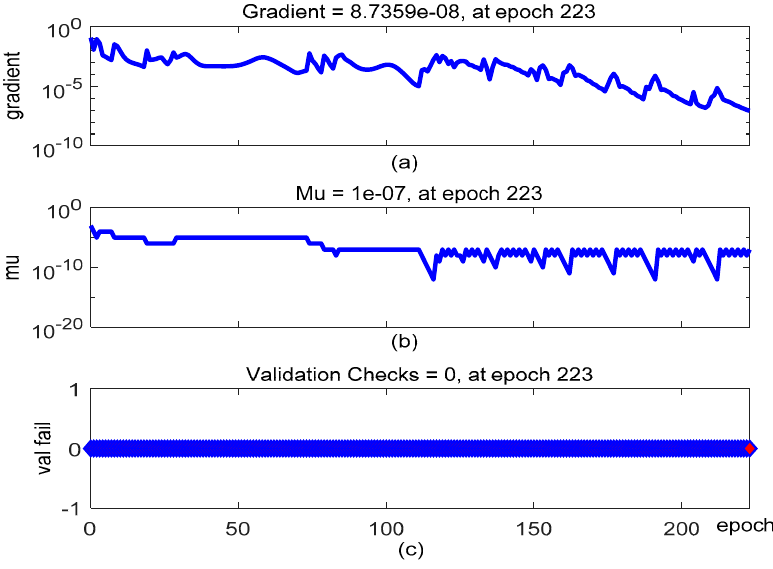
Figure 7. The training parameter curve. ( a ) Gradient ( b ) Mu ( c ) validation fail.